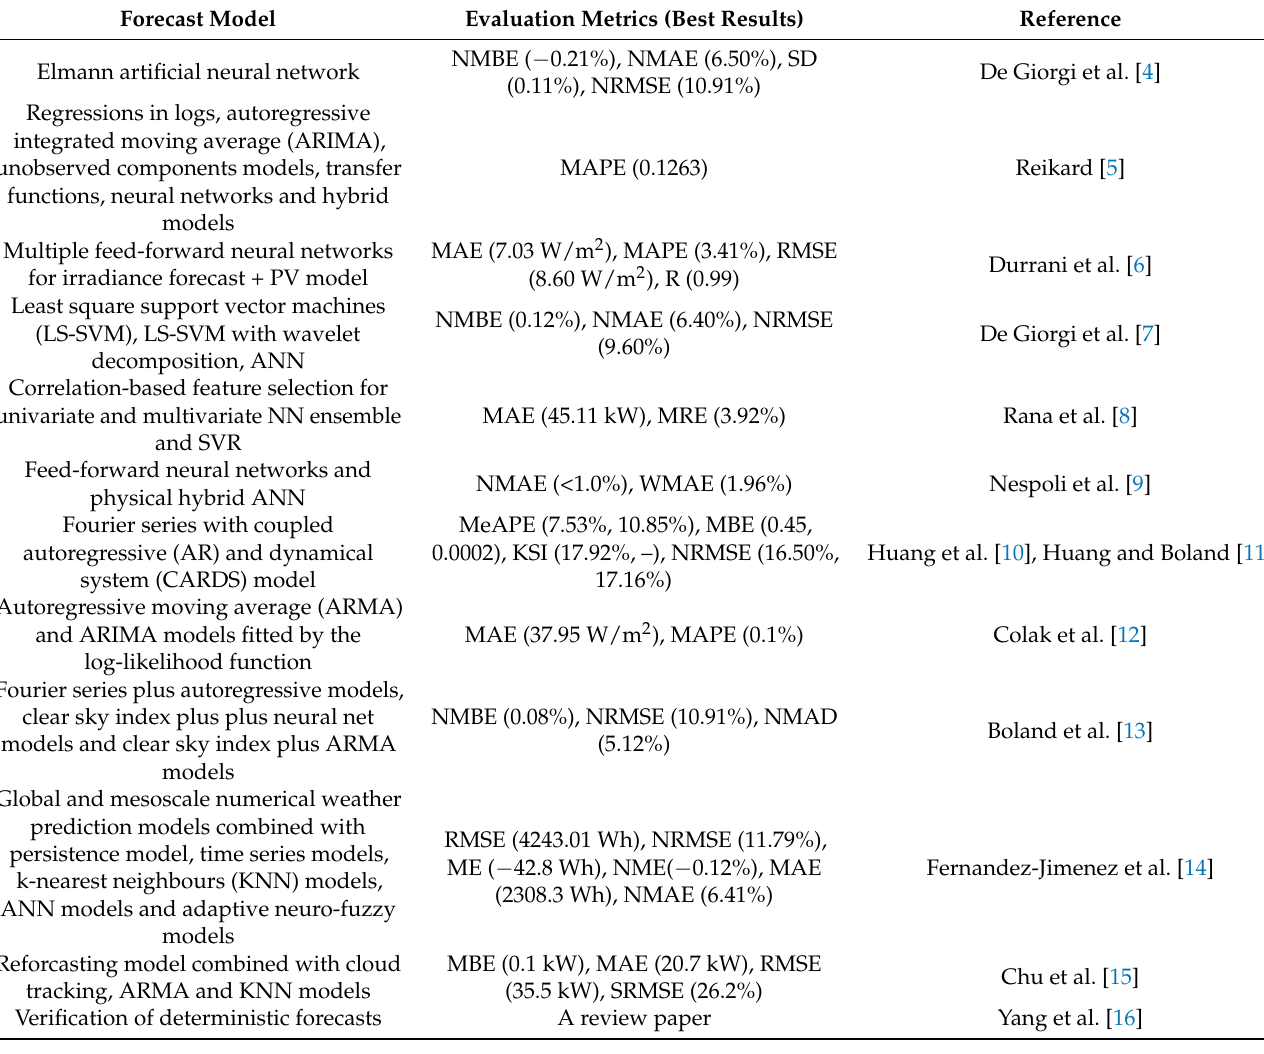
Table 1. Point forecasting.